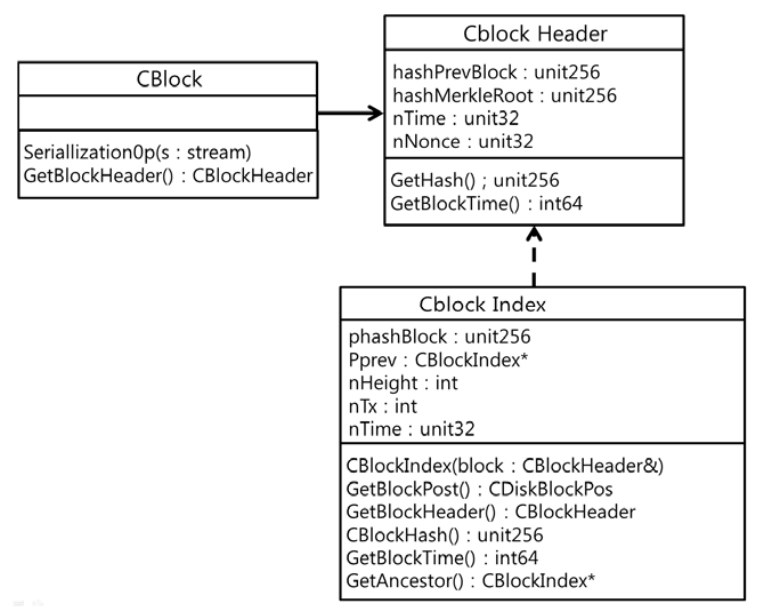
Figure 21. CBlock class.